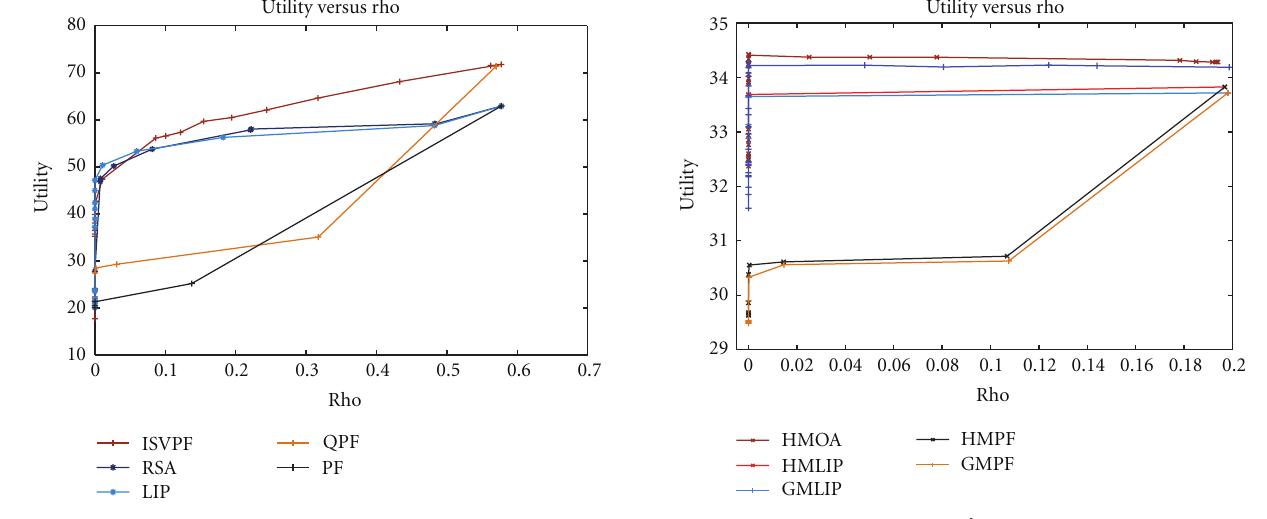
Figure 13: Utility ( (cid:26) Ψ ) versus Rho ( (cid:26) χ